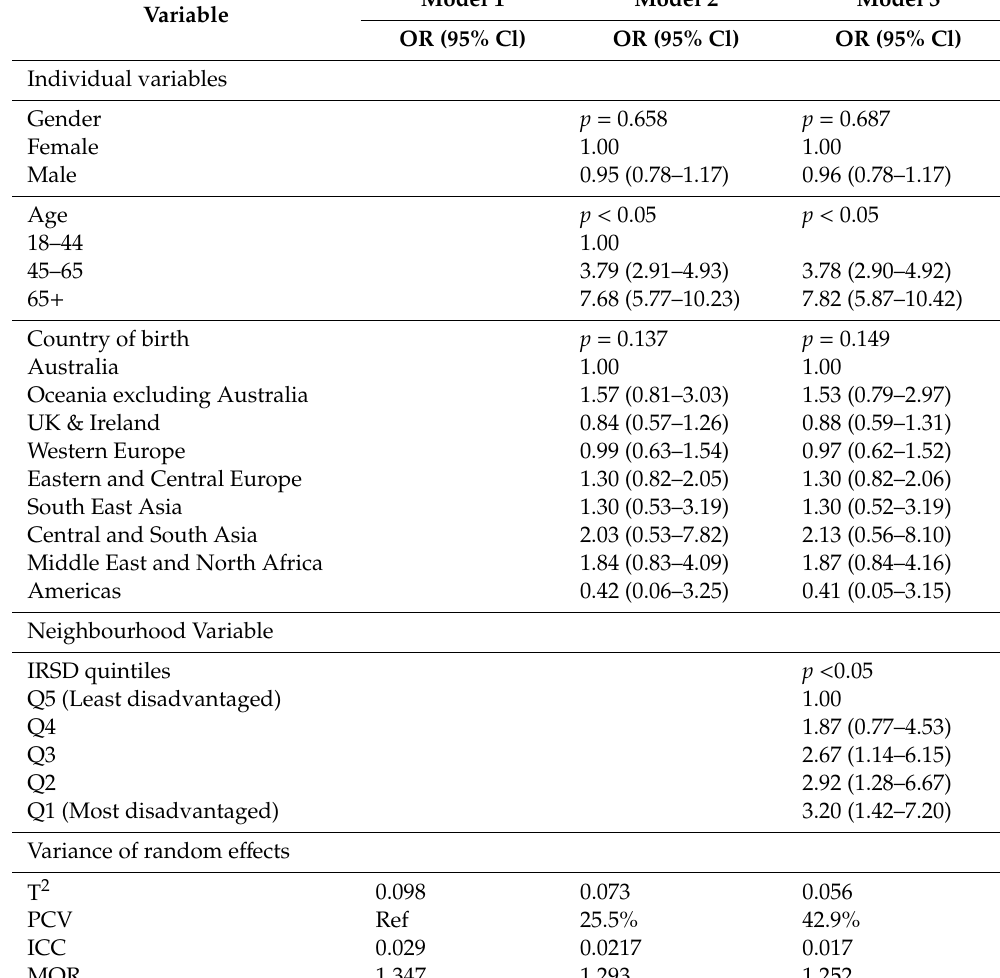
Table 2. The association between neighbourhood socioeconomic disadvantage and serious mental illness (SMI)–type 2 diabetes (T2D) comorbidity using multilevel analysis (Illawarra – Shoalhaven,